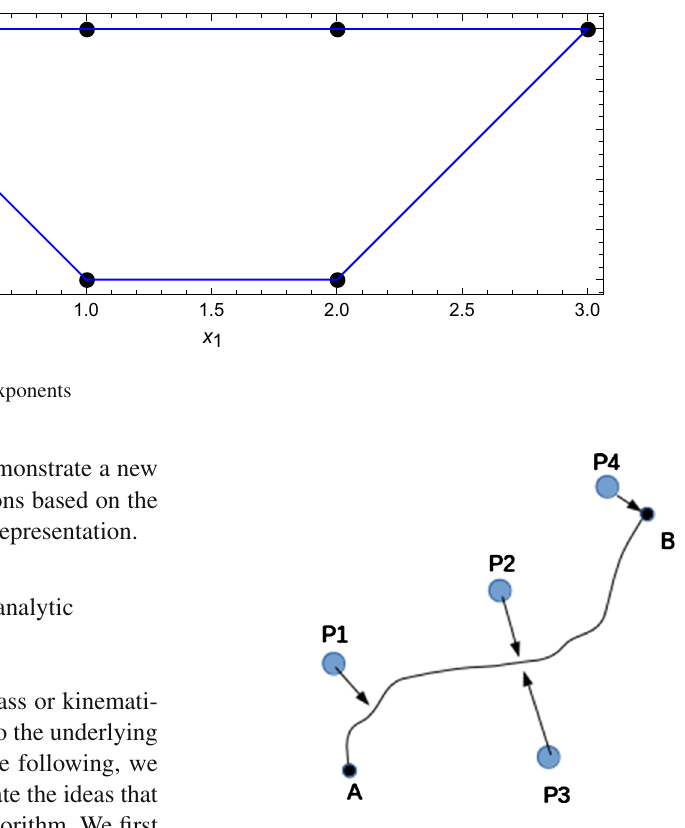
Fig. 3 Types of singularities: P1 is a simple pole, P2 and P3 are Pinched Singularities and P4 is an End Point Singularity. While the contour between the points A and B can be deformed so as to avoid the simple pole P 1, the same is not true for the pinch and end-point